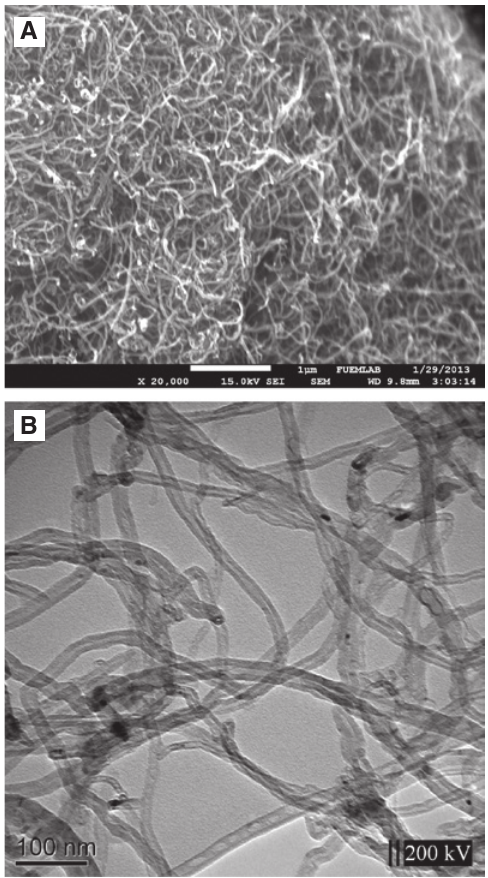
Figure 2 (A) SEM images, (B) HR-TEM images of carbon nanotubes synthesized via CVD method.